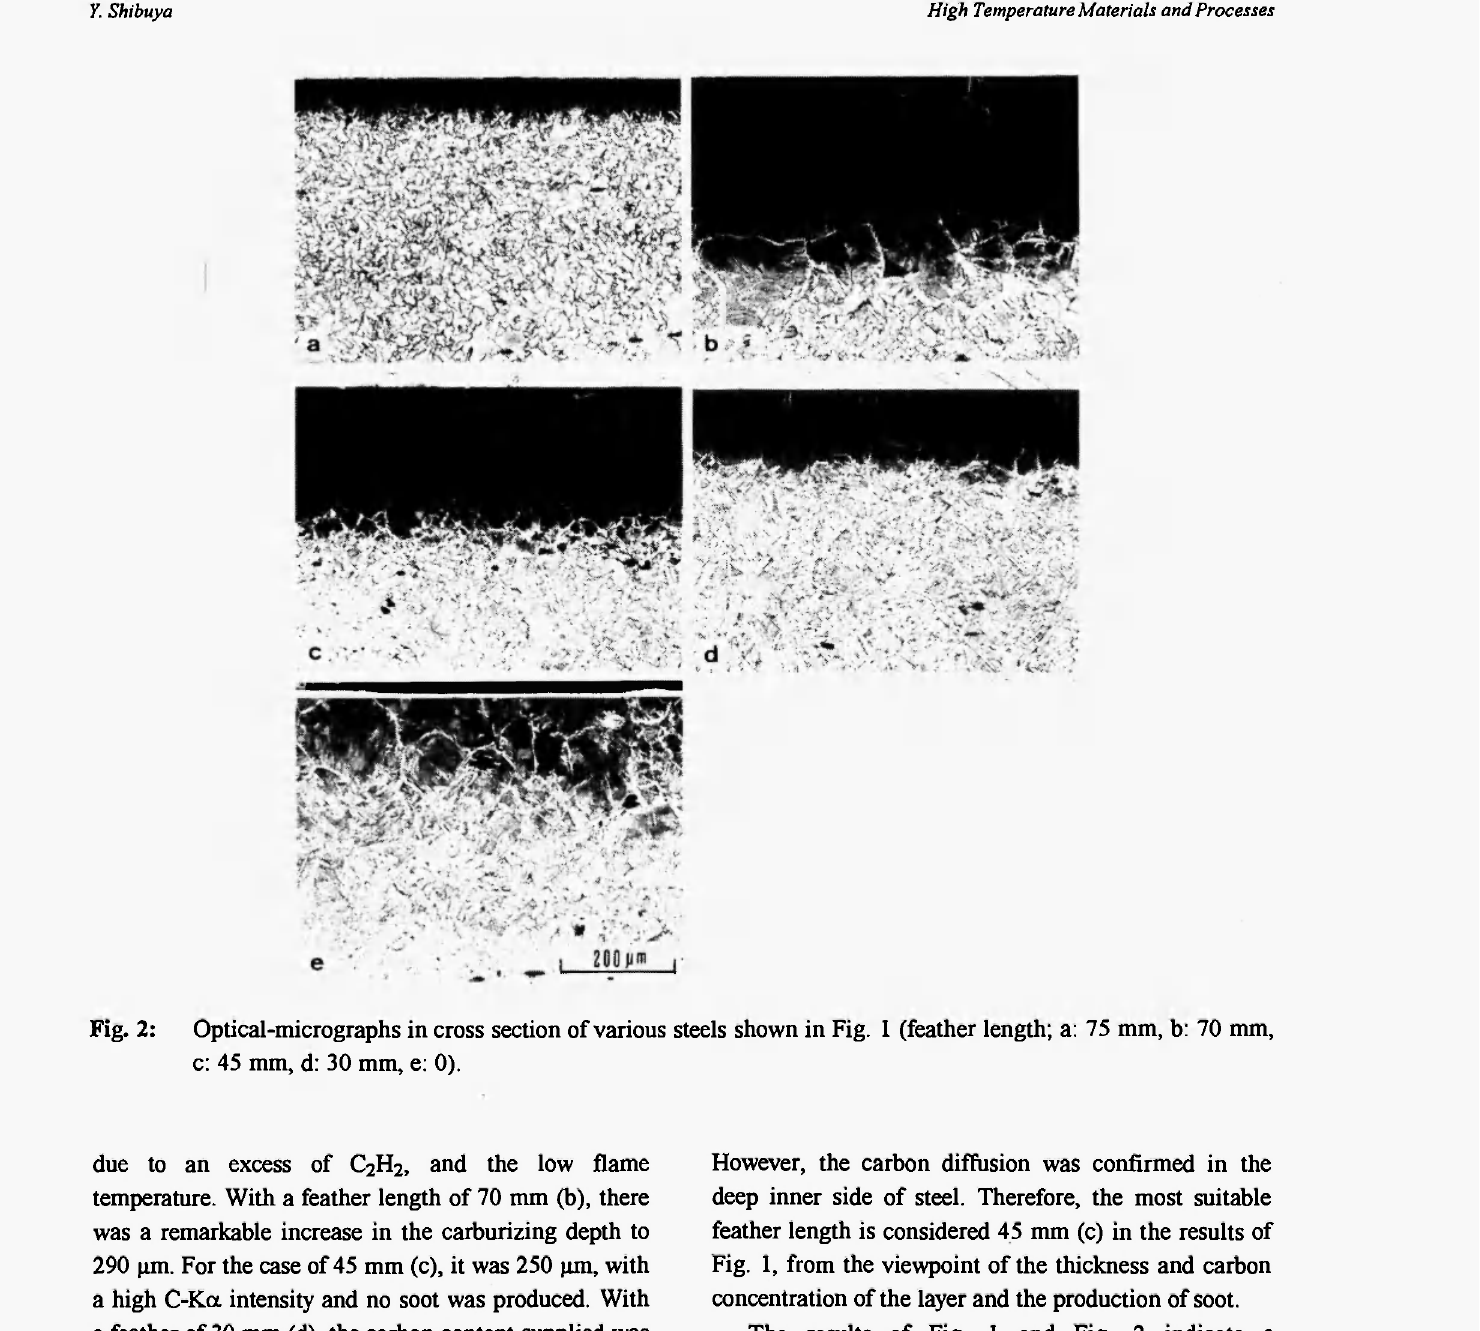
Fig. 2: Optical-micrographs in cross section of various steels shown in Fig. 1 (feather length; a: 75 mm, b: 70 mm, c: 45 mm, d: 30 mm, e: